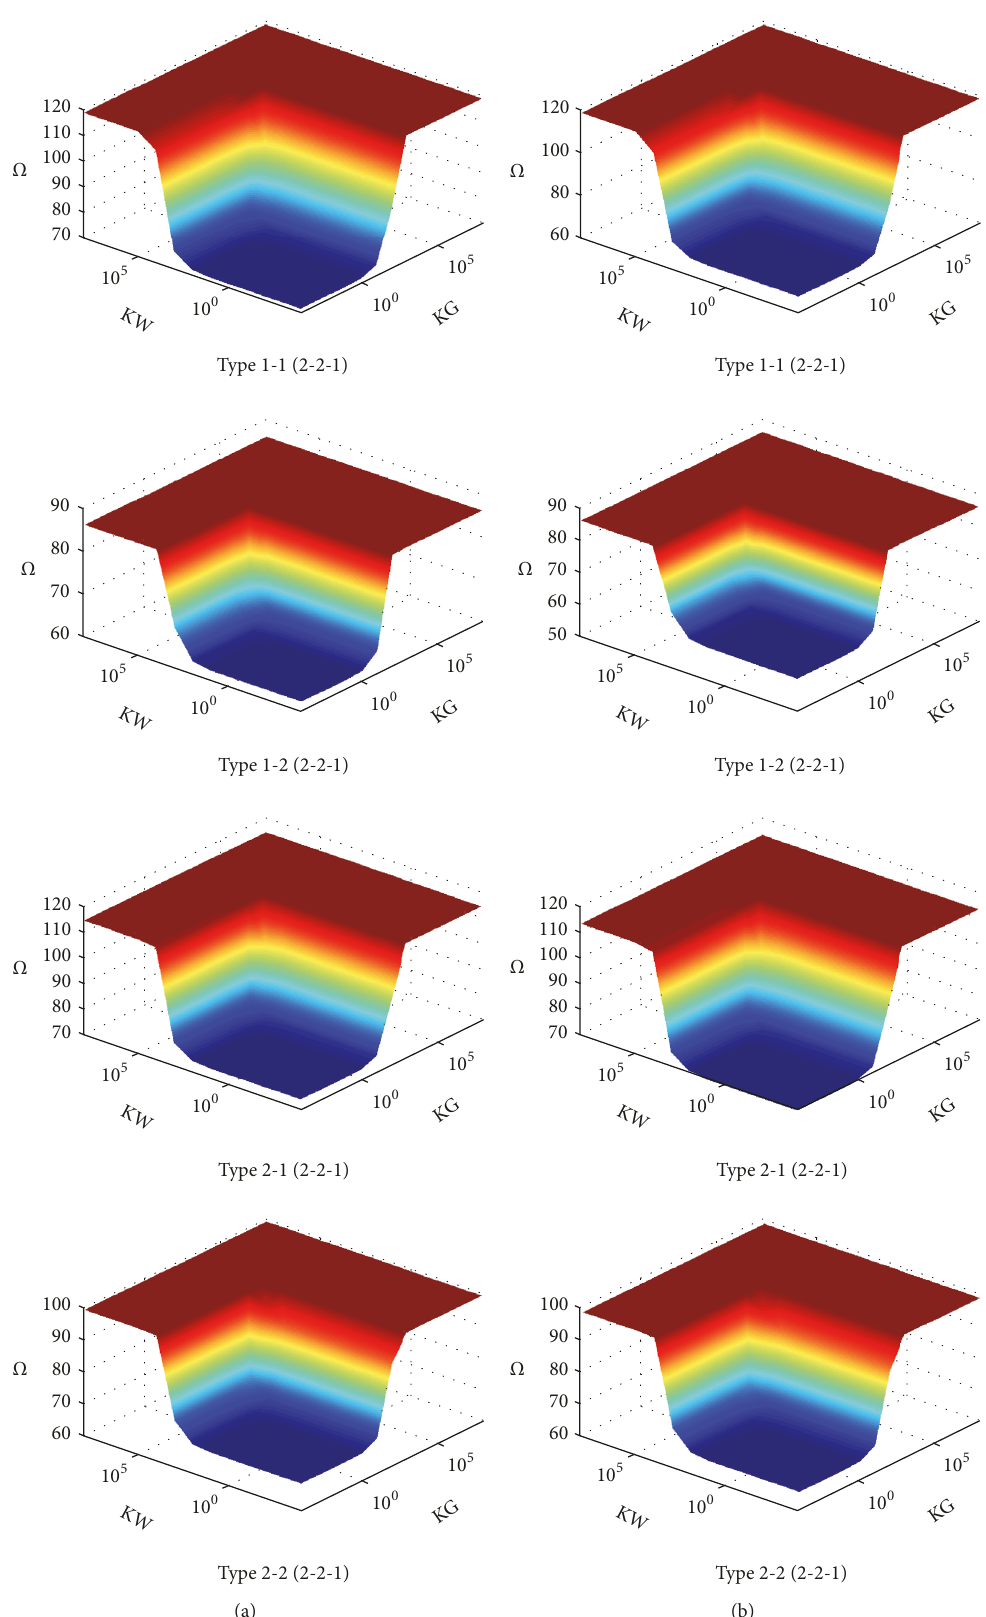
Figure 15: Variation of the frequency parameters Ω versus the elastic foundation coefficients for annular sector plates with different boundary conditions: (a) CCCC; (b) E 2 E 2 E 2 E 2